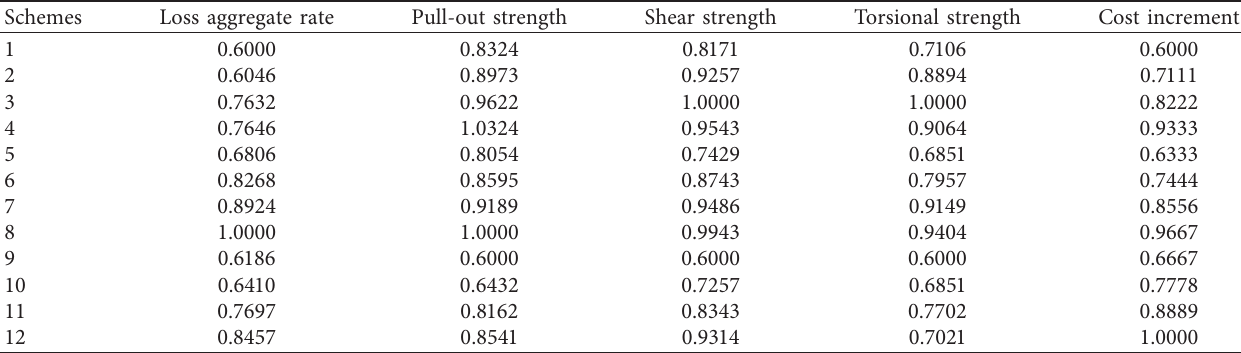
Table 7: Single-effect coefficient of evaluation indexes.